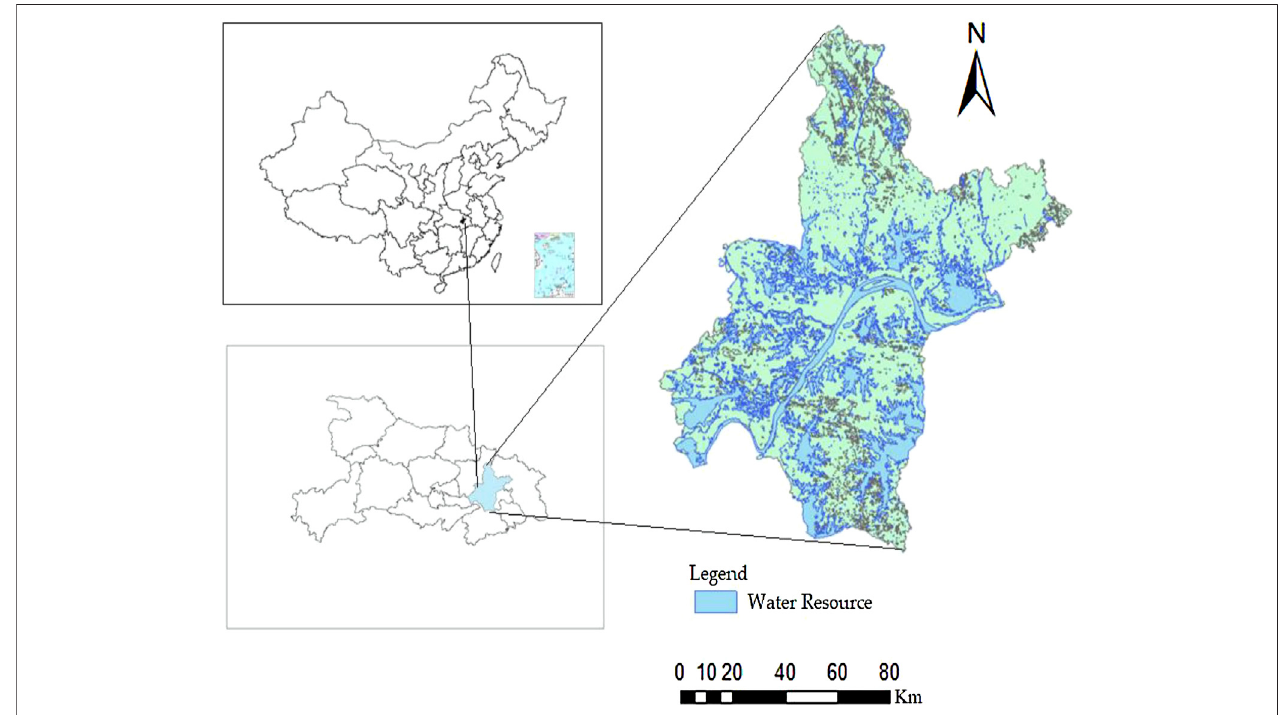
FIGURE 2 | Geographical distribution of Wuhan ’ s water resources (Source: Zhang et al., 2019).